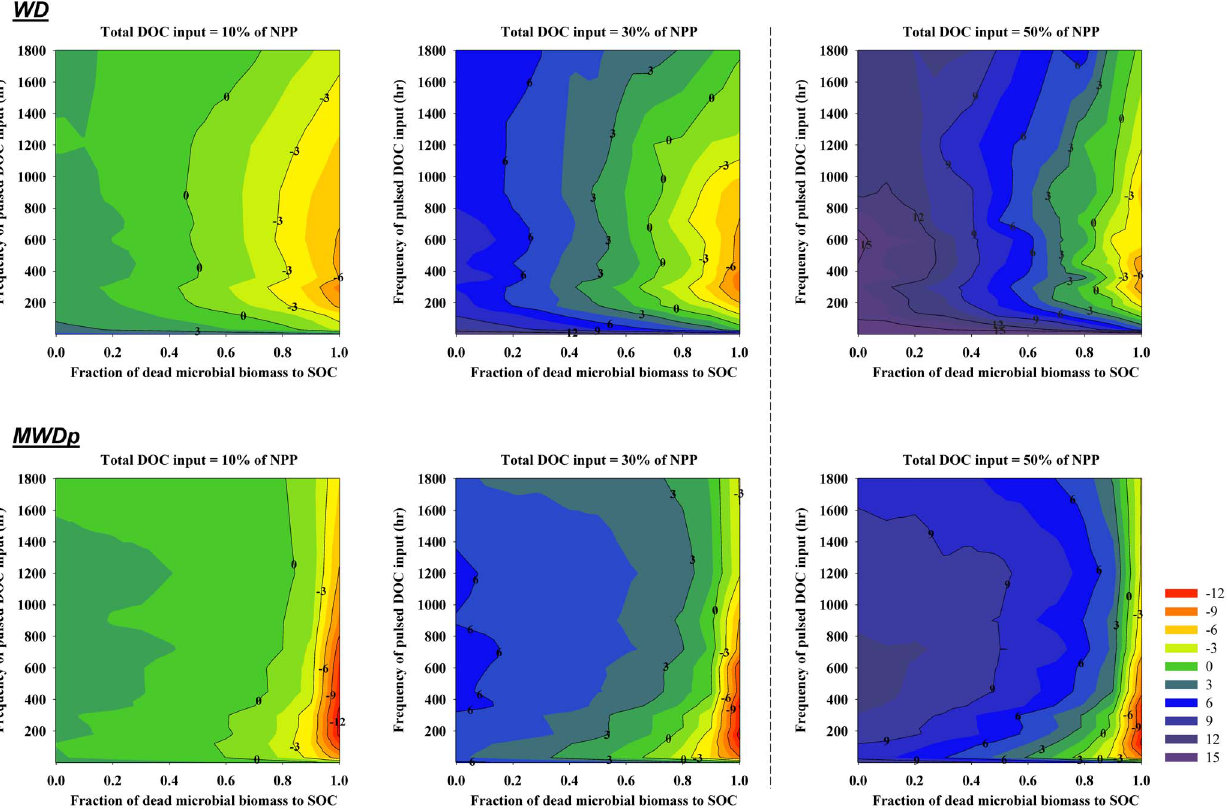
Figure 3. Variations in simulated priming effects (g OC m 2 2 yr 2 1 ) associated with different amounts of total DOC input at each site (WD and MWDp) as affected by different frequencies and intensities of DOC input (Y axis) and the quality of microbial necromass (as represented by the fraction of microbial necromass apportioned to SOC). The simulated heterotrophic respiration induced by DOC input equal to 50% of annual NPP was greater than the upper limit of measured heterotrophic respiration, but was included for comparison purposes.